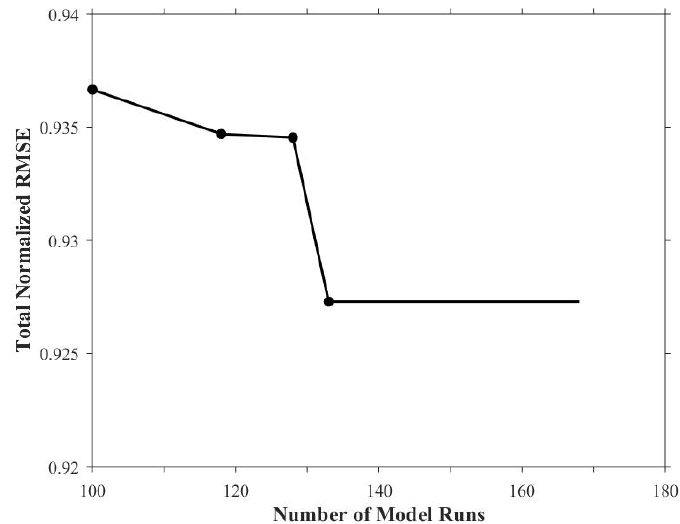
Figure 4. Optimization speed for evapotranspiration simulation in Community Land Model version 4.0 using the adaptive surrogate modeling-based optimization method.